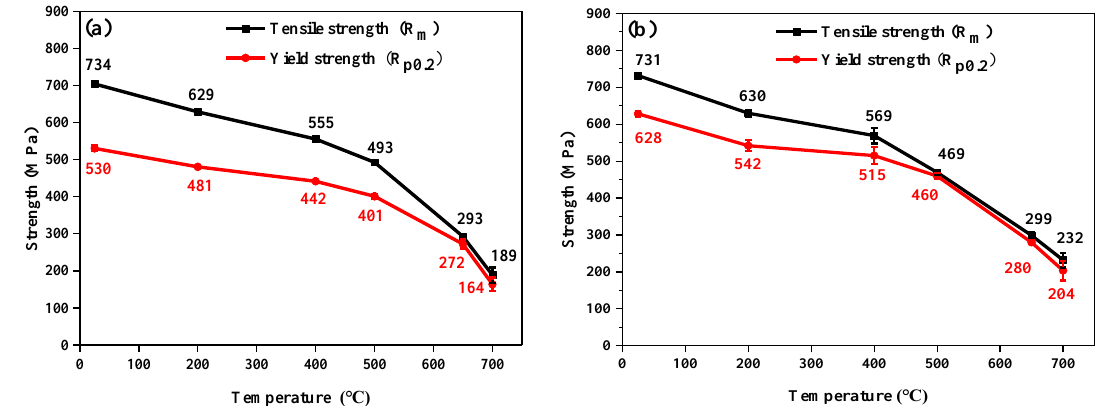
Figure 3. Relationship between the temperature and strength of heat resistant steel at different temperatures: ( a ) 9Cr–1.5Mo–1Co and ( b ) 9Cr–3W–3Co.